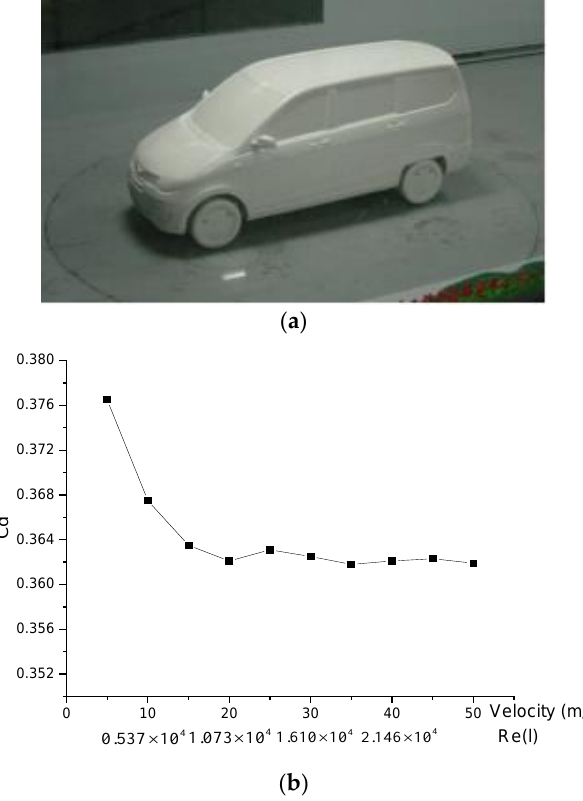
Figure 3. ( a ) Wind tunnel test of the original model. ( b )Wind tunnel results: drag coefficient versus different wind speed and Reynolds numbers. Table 3. Comparison of the CFD simulation result and the experiment data.